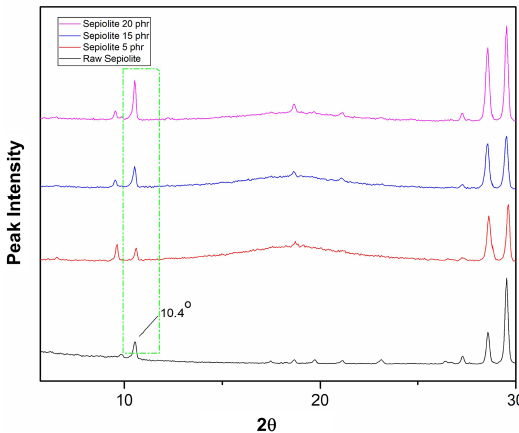
Figure 3. XRD patterns of raw sepiolite and sepiloite filled NR composites.